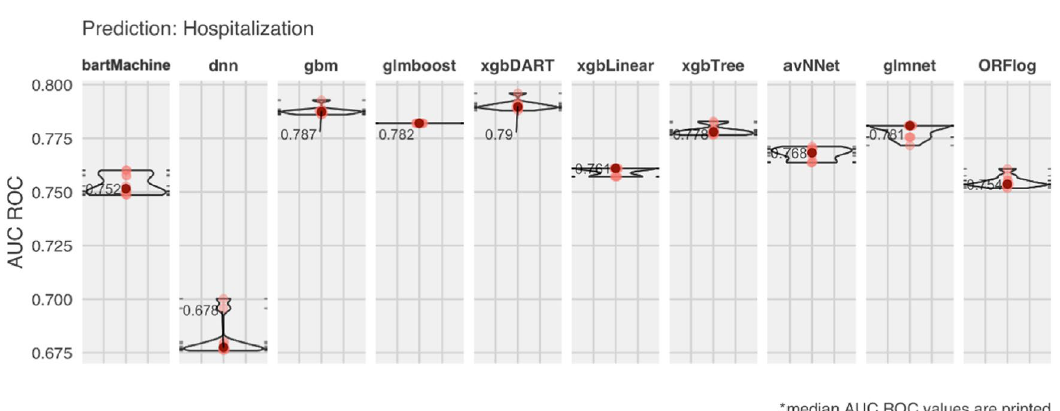
Algorithms from right to left: bartMachine: Bayesian Additive Regression Trees, dnn: Stacked AutoEncoder Deep Neural Network, gbm: Stochastic Gradient Boosting, glmboost: Boosted Generalized Linear Model, xgbDART: eXtreme Gradient Boosting (xgb) with DART booster, linear model solver (xgbLinear), tree learning (xgbTree), avNNet: model-averaged Neural Network, glmnet: Elastic-Net regularized generalized linear model, and ORFlog: Oblique random forest. Figure 2. AUC ROC result of the preliminary classification (phase 1) for predicting